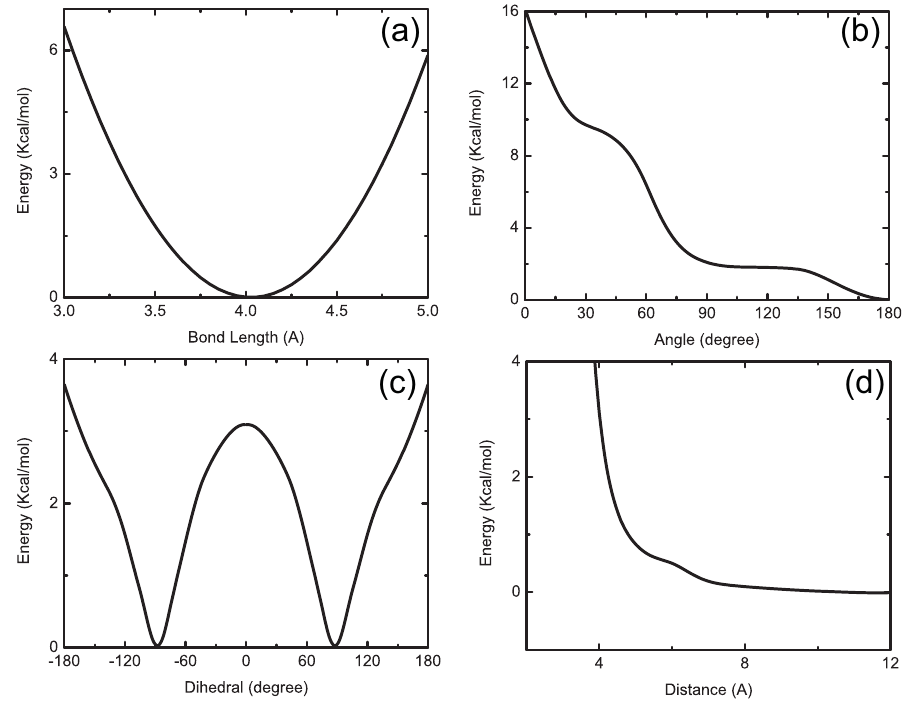
Figure 9. Optimized potential functions for ( a ) bond; ( b ) angle; ( c ) dihedral and ( d ) pair interactions of coarse-grained cis -PI melts at 413 K. Figure reproduced with permission from